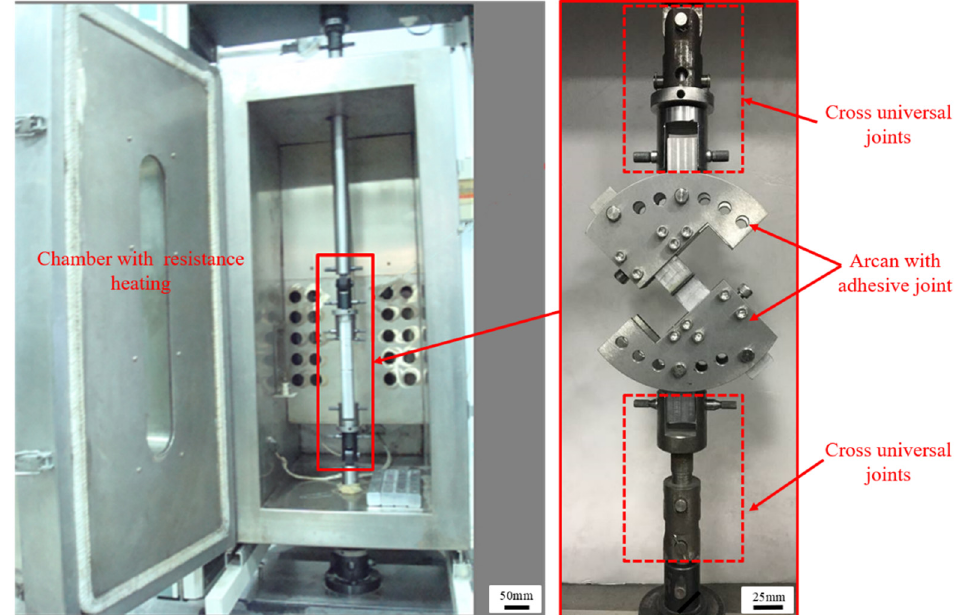
Figure 5. Quasi-static mechanical properties test at different temperatures.